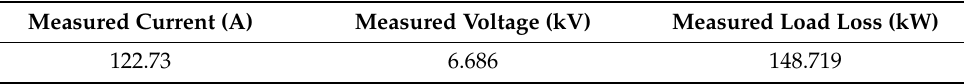
Table 3. Experiment results of load test (HV supplied, MV short-circuit, LV open-circuit). Measured Current (A) Measured Voltage (kV)